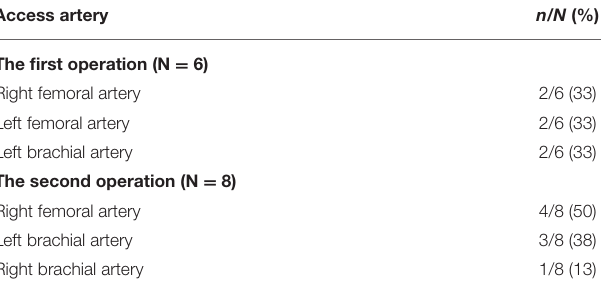
TABLE 4 | The choice of access artery for embolization.